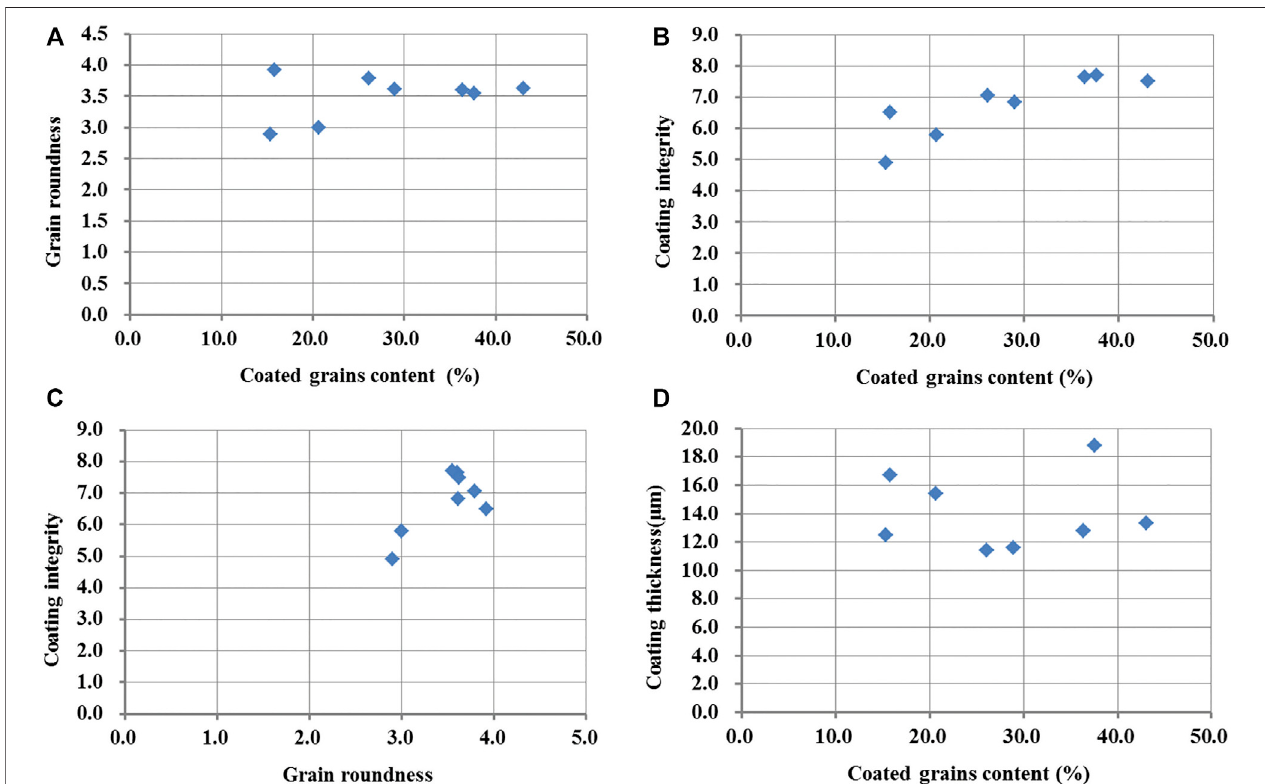
FIGURE5| Correlation betweencoatedgraincontentandcarbonatecoatcharacteristics. (A) Cross-plotofgrainrounded versuscoatedgraincontent. (B) Cross- plot of coating integrity versus coated grain content. (C) Cross-plot of coating integrity versus grain rounded. (D) Cross-plot of coating thickness versus coated grain